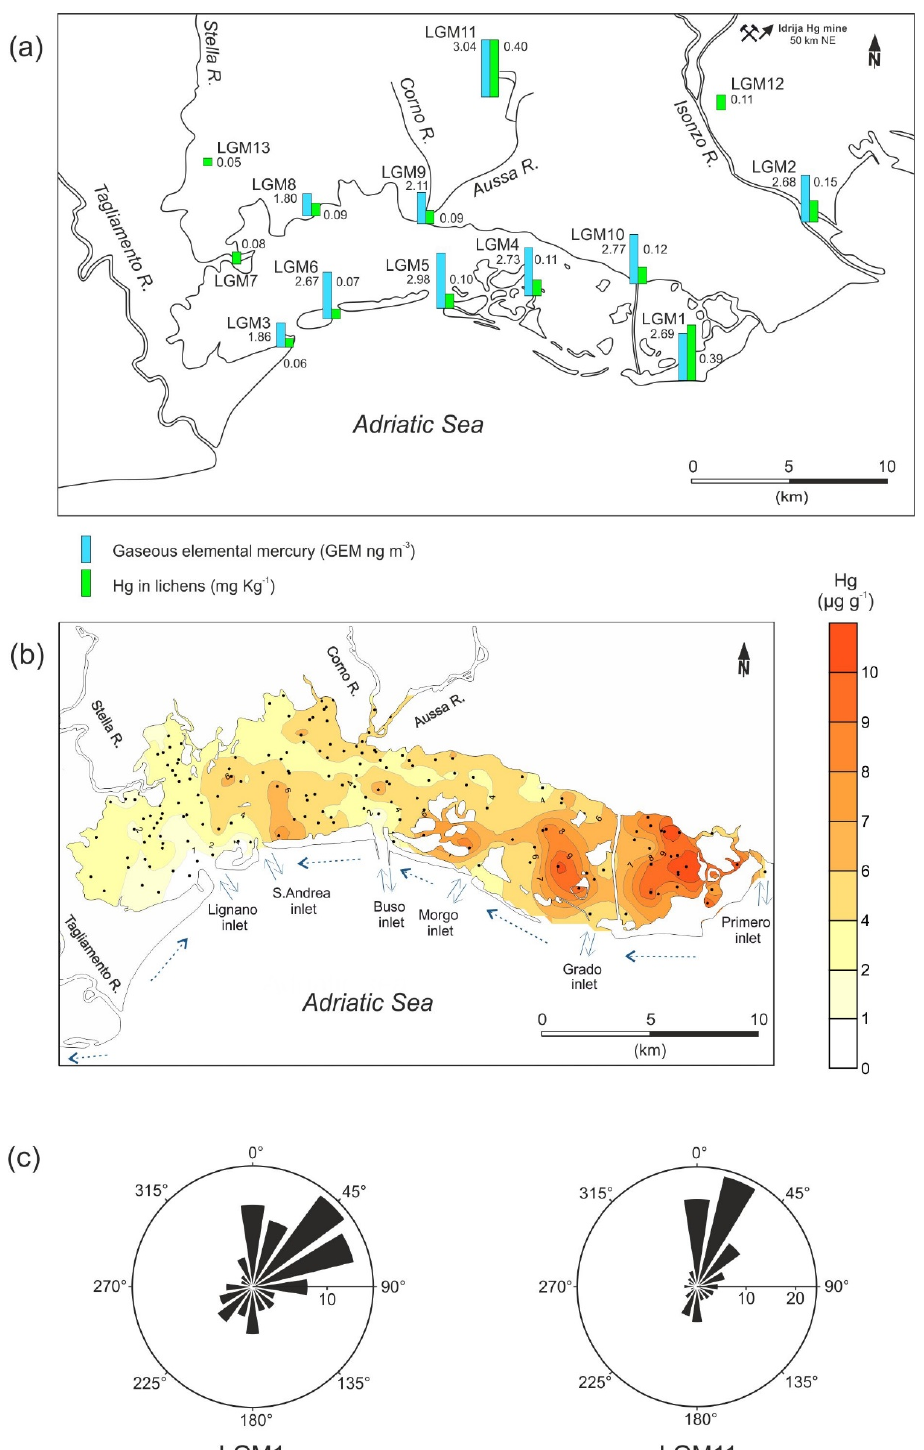
Figure 3. ( a ) GEM concentrations (light blue) and Hg contents in lichens (green). ( b ) Distribution of Hg concentrations in the sediments of the Marano and Grado Lagoon (modified from [48]); dotted arrows represent longshore currents and related sediment transport, simple arrows indicate tidal fluxes through the lagoon inlets. ( c ) Wind rose for LGM1 (Grado) and LGM11 (Torviscosa, CAP) calculated from 2013 wind data in selected sites. The radius length indicates the frequency of wind directions.